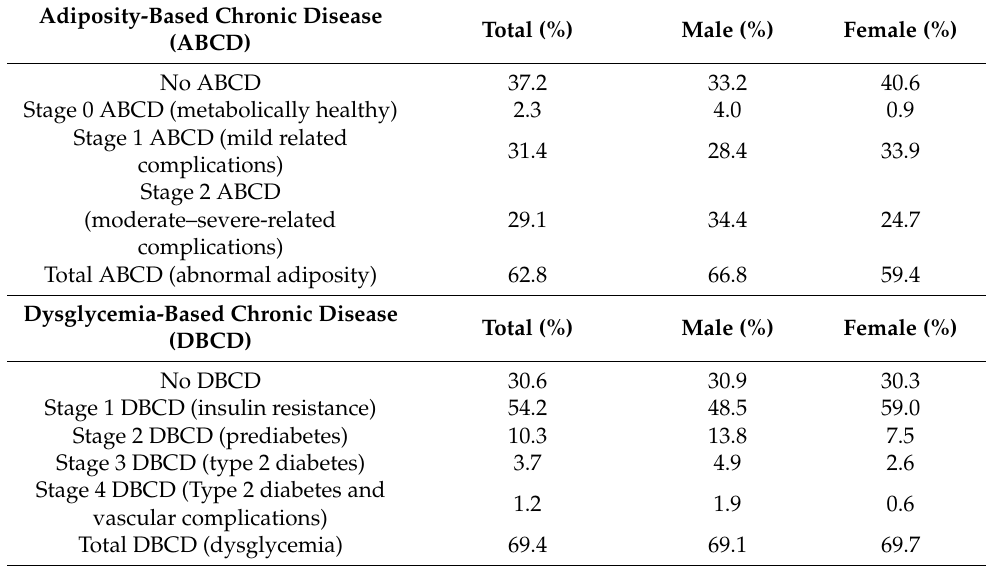
Table 3. Prevalence of adiposity- [25] and dysglycemia- [26] based chronic disease in a Czech population